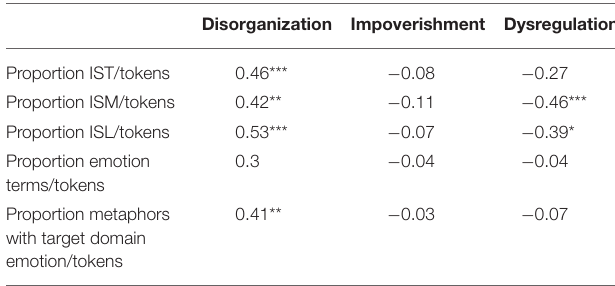
TABLE 4 | Correlation analyses for the elicited speech production task: TLI-dimensions and proportion of internal state expressions. Disorganization Impoverishment Dysregulation